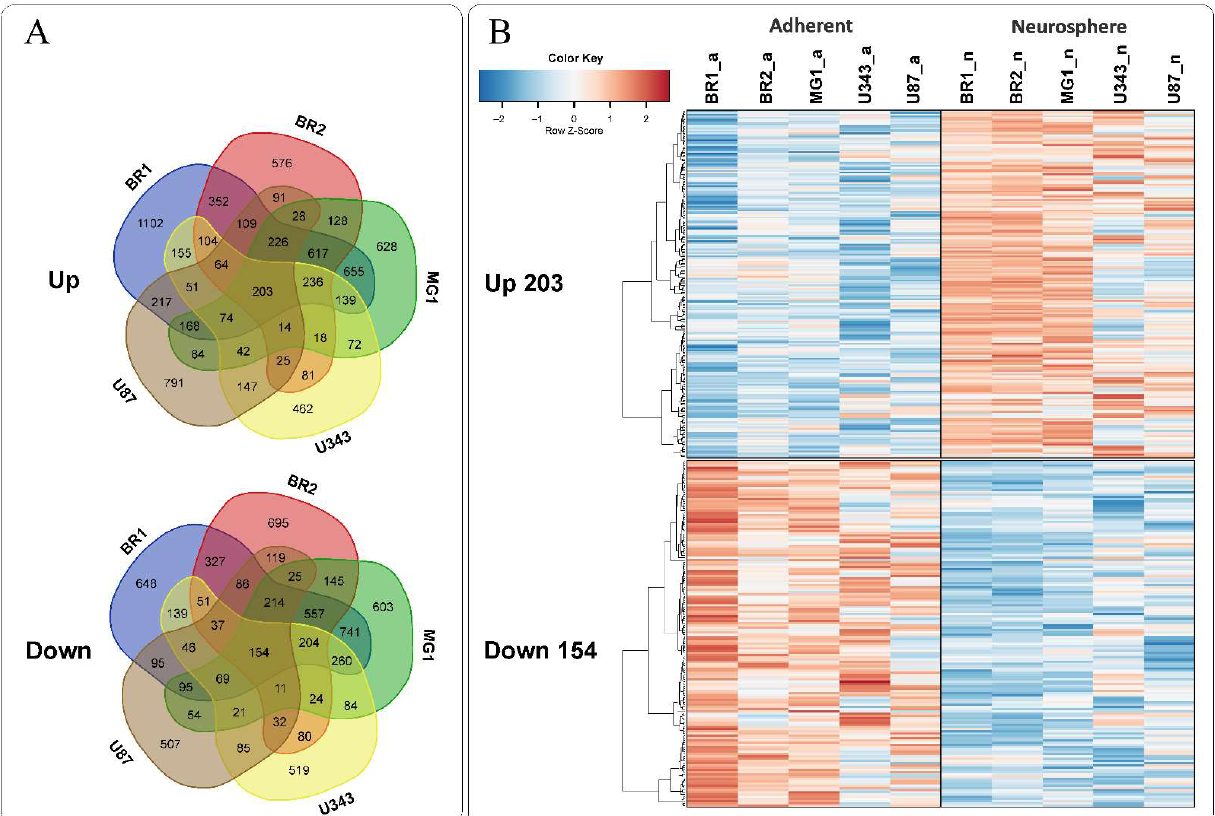
Figure 3. ( A ) Venn diagrams showing intersections of gene sets in selected glioma cultures, separately for genes with increased (Up) and decreased (Down) levels compared to the corresponding MN cells. ( B ) Heatmaps of 203 commonly upregulated and 154 commonly downregulated genes in NS vs. MN glioma cells.